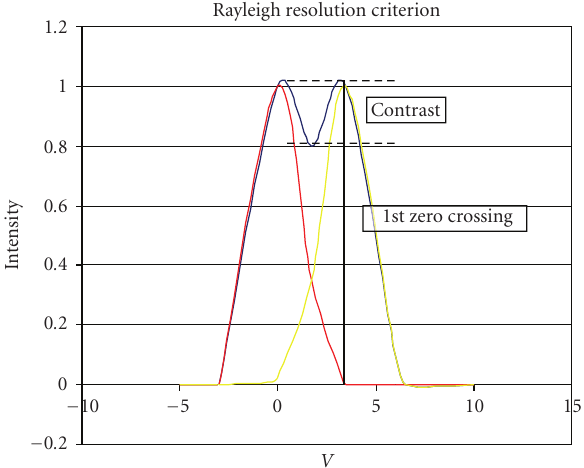
Figure 2: According to the Rayleigh law, two objects are visible if they are located at 0.61 λ /NA distance and have a contrast of 26%, because lateral resolution depends on luminosity and contrast of the